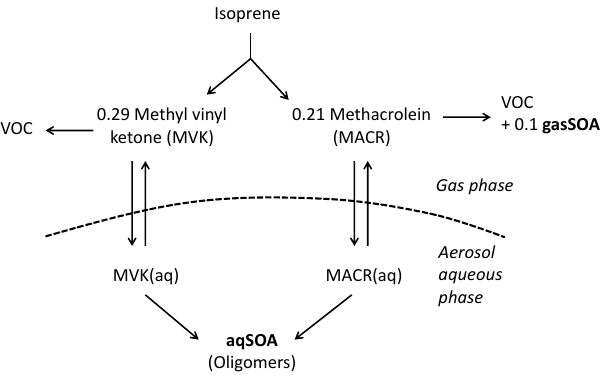
Figure 7. Schematic of SOA formation from isoprene in the atmo- spheric multiphase system; parameters for all processes are summa- rized in Tables